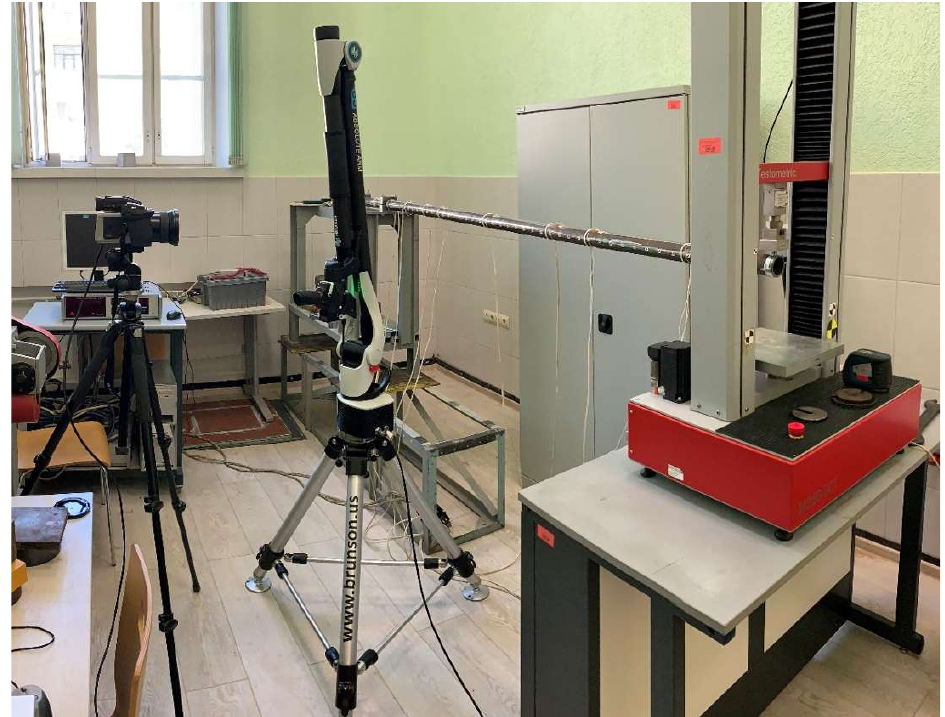
Figure 12. Workspace during the experiment. Prior to the experiment, the investigated pipeline is cleaned with a grinder in places where markers are glued for better adhesion. Cross markers are glued along the side generatrix every 5 cm, photographed using a Hasselblad H5D 200 MS camera. The pipeline in a bent state is shown in Figure 13.